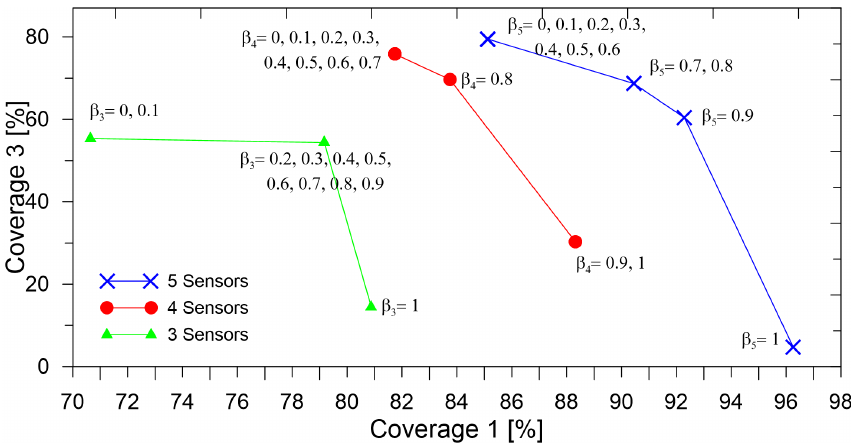
Figure 17. Pareto front for different values of β for different numbers of